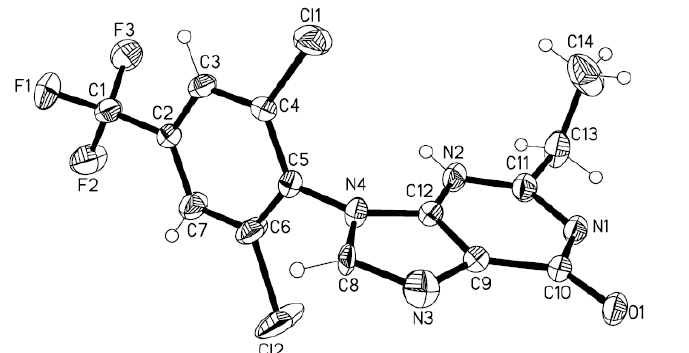
Figure 1. Single crystal X-ray crystal structure of 2c